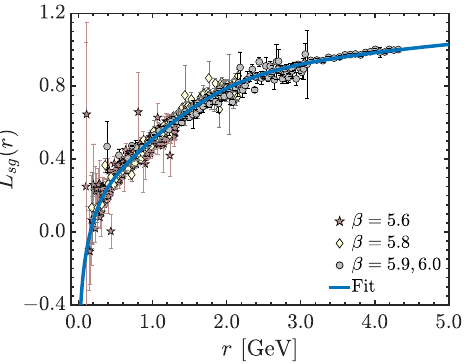
Figure 11. Lattice data from Reference [84] for L sg ( q ) , compared to the fit for it given by Equation (C12) of [124] (blue continuous